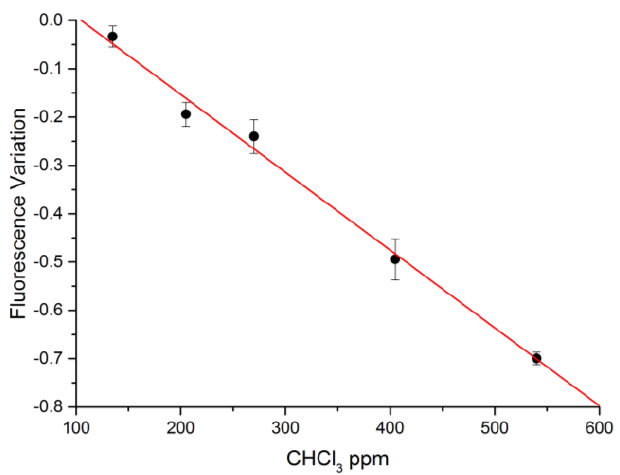
Figure 7. Fluorescence maximum variation as a function of chloroform concentration (ppm, expressed as vol ratio of vaporized chloroform in the measuring chamber).